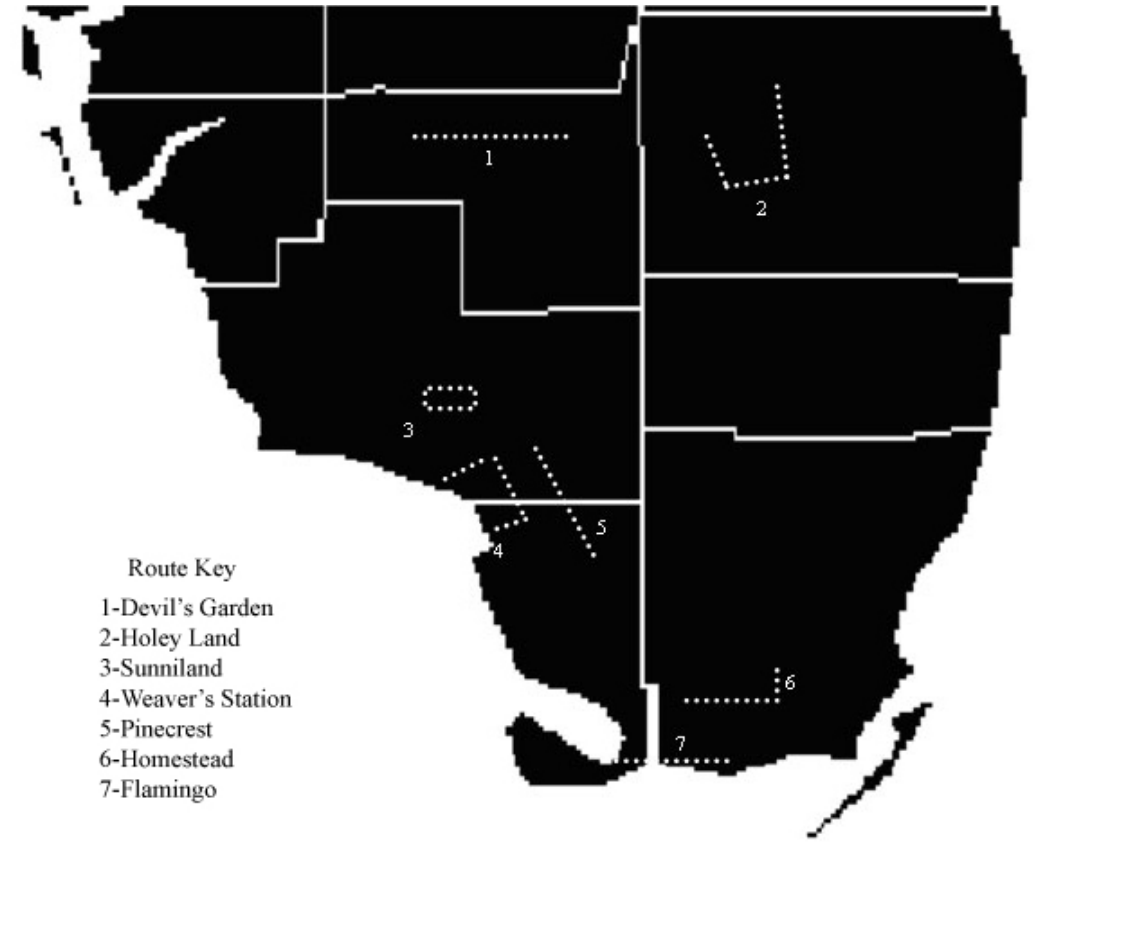
Fig. 2. Map of southern Florida with Breeding Bird Survey routes used for this study. Routes include Devil’s Garden, Holey Land, Homestead, Pinecrest, Sunniland, Weaver’s Station, and